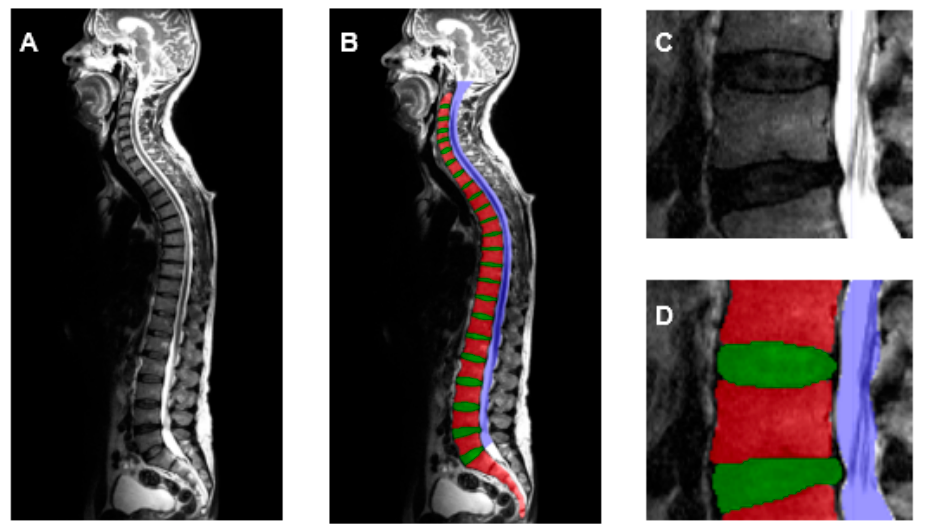
Figure 3. T2-weighted sagittal images of the entire spine ( A ) with segmentation by the AI algorithm ( B ) of the vertebral bodies (red), intervertebral discs (green) and spinal canal (blue). Enlarged view of the lumbar spine without ( C ) and after AI segmentation ( D ).